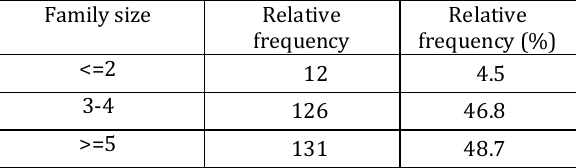
Table 7. Family size of the forest park visitors